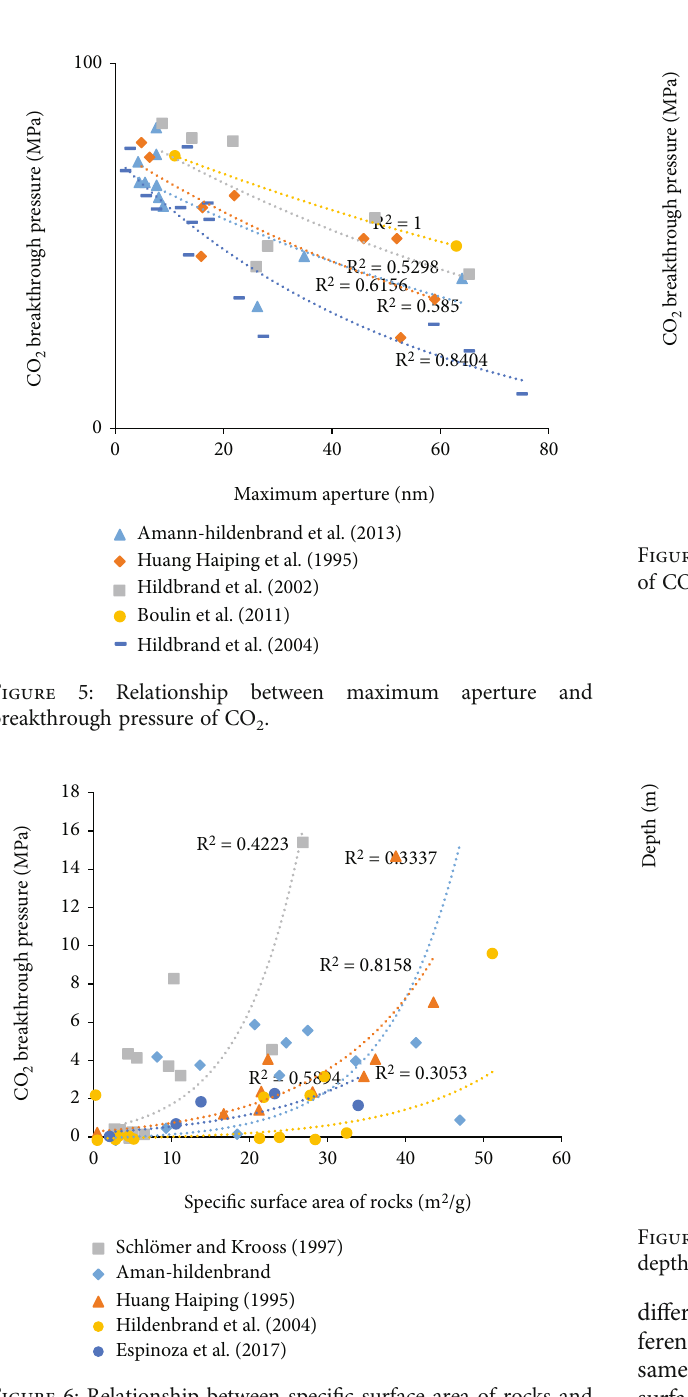
Figure 6: Relationship between speci fi c surface area of rocks and breakthrough pressure. CO 2